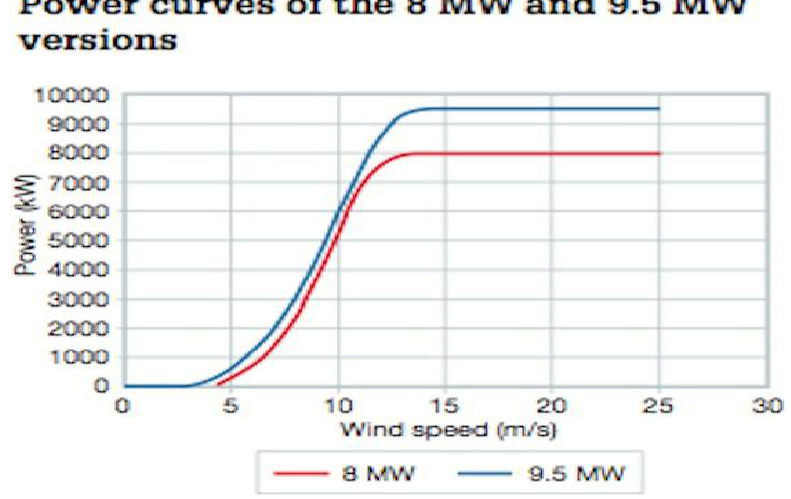
Figure 1. Wind turbine power curves (8 MW and 9.5 MW, MHI-Vestas V164).